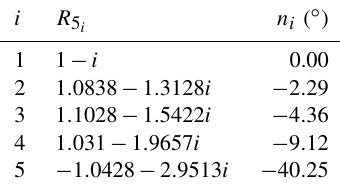
in this planar mechanism. The orientations of the links R 2 R 3 , Table 1. The design parameters.